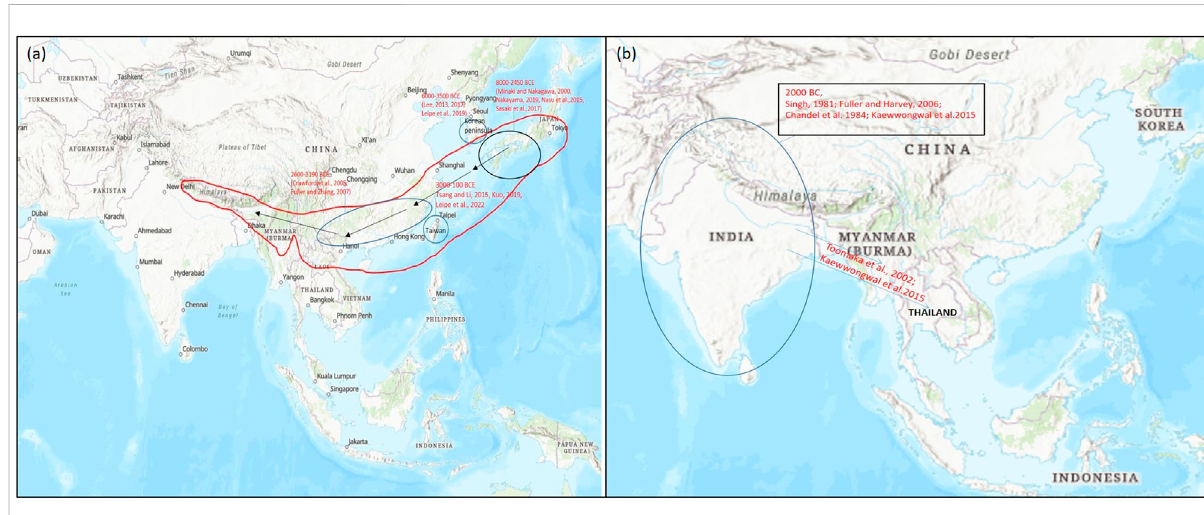
FIGURE 2 Map representing the origin of domestication of (A) azuki bean ( Vigna angularis ) and (B) black gram ( Vigna mungo ) (encircled) and their spread (arrow) to different parts of the world based on archeological evidences and genetic studies for domestication-related traits. Map source: https://